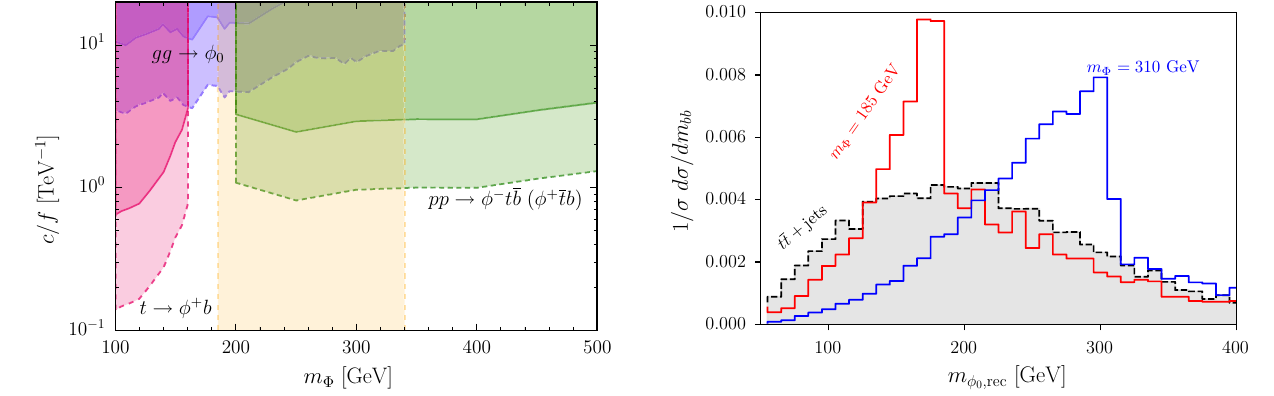
Fig. 9 Current (solid) and future (dashed) bounds on the parameter space ( m (cid:2) , c / f ) . The red region to the left comes from LHC searches for rare top decays, t → b φ ± ,φ ± → jets; see Ref. [65]. The upper blue region comes from LHC searches for single production of φ 0 → bb via gluon fusion; see Ref. [66]. The green region to the right comes from LHC searches for single production of φ ± in association with a top and a bottom quark; see Ref. [67]. The middle vertical orange band is the region that could be tested using our dedicated analysis